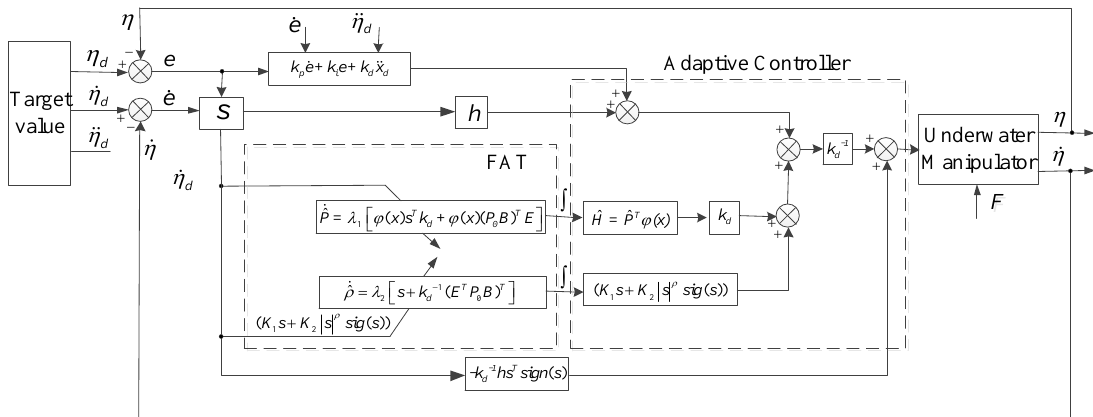
Figure 1. The control system block diagram of the proposed controller.